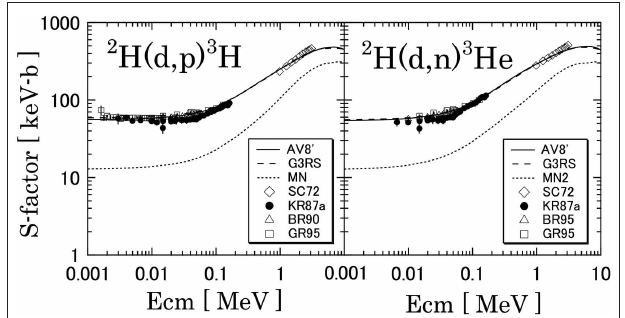
FIGURE 2 | 2 H(d,p) 3 H and 2 H(d,n) 3 He astrophysical S -factors calculated with the realistic AV8 ′ + G3RS potential (solid lines) and with the effective MN potential (dotted lines). See Angulo et al. (1999) for the experimental data. Reprinted figure with permission from Arai et al. (2011). Copyright (2011) by the American Physical